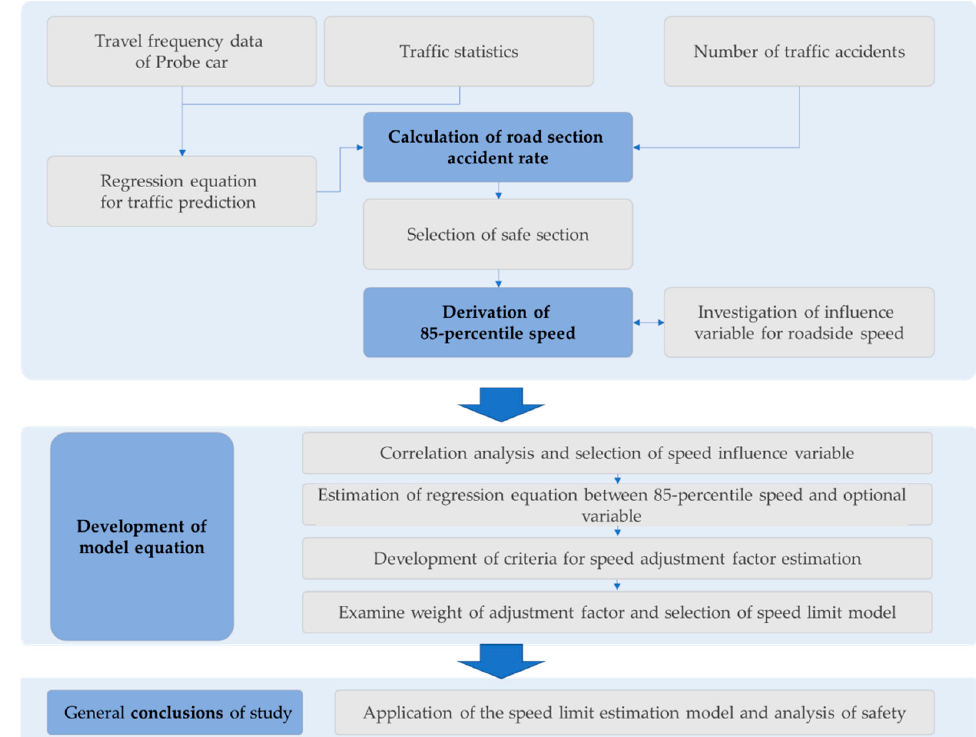
Figure 6. Speed limit estimation model development process.